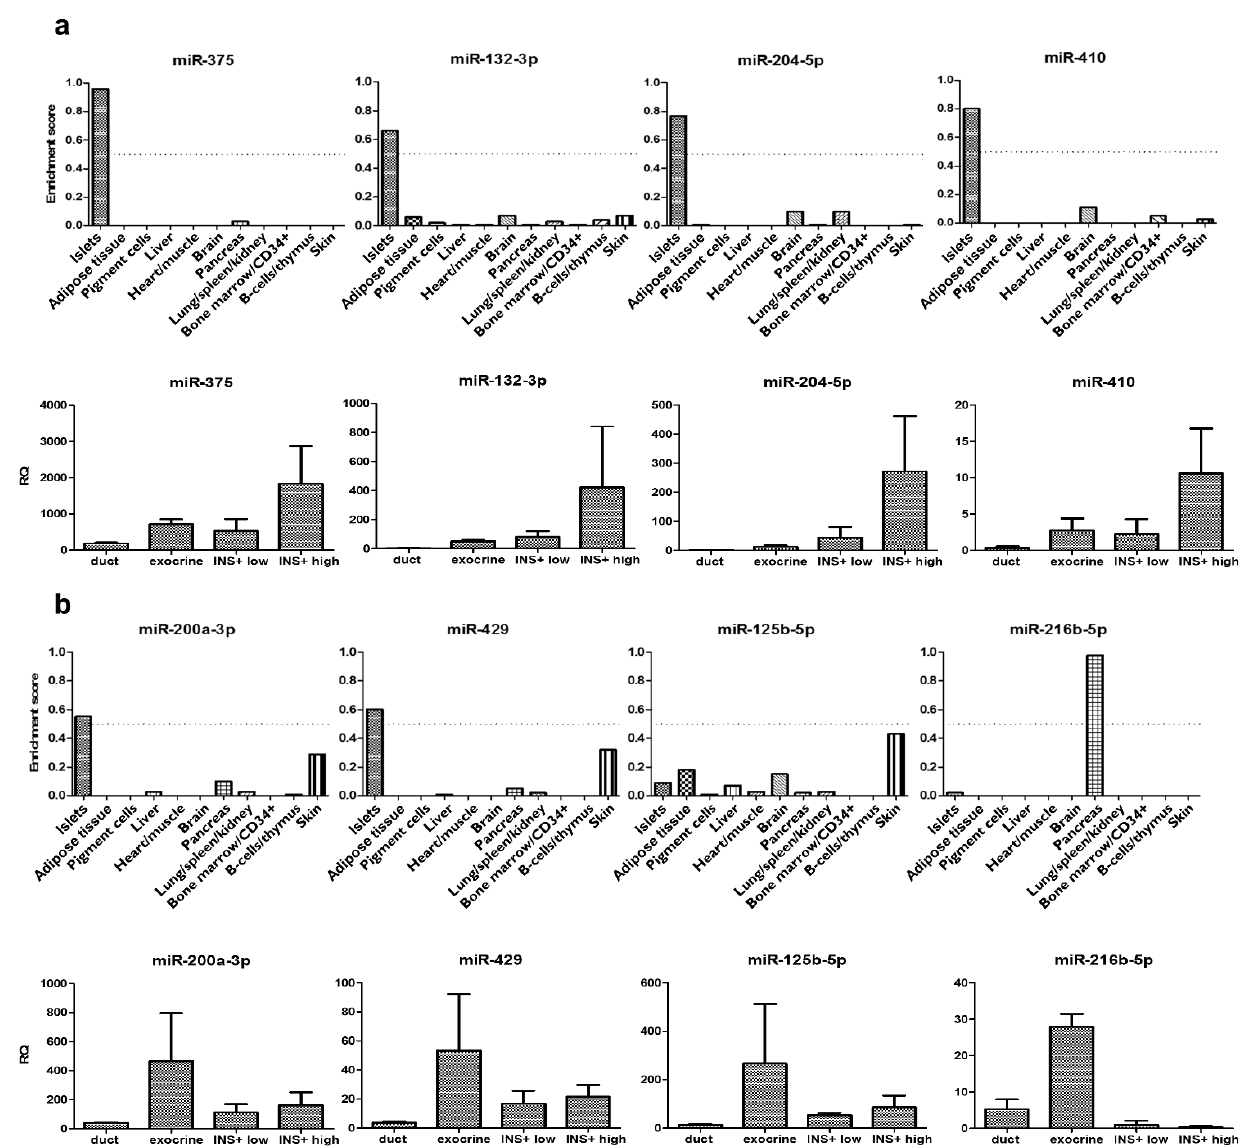
Figure 3. Relative expression levels in human pancreatic cell fractions. ( a ). set of 4 microRNA with a relative islet endocrine- enriched expression and ( b ) set of 4 microRNA with a relative pancreatic exocrine cell-enriched expression. For each set, the upper panel indicates a tissue-comparative enrichment score obtained by next-generation sequencing in human pancreatic islets ( n = 3 isolates from 6 organs) versus the other indicated tissues as derived from a public data set [10] and the lower panel the RQ measured in this study on cell preparations of human pancreas (all from n = 3 independent organ preparations), enriched in duct cells, exocrine acinar cells and islet endocrine-enriched fractions with lower (INS + low) or higher (INS + high) percentage insulin-positive cells. These fractions respectively contained 0.4%, 1.5%, 8.3% and 61.0% insulin-positive cells. Table 2. Correlation between post-transplant microRNA levels and cellular composition of the islet graft and with secre- tory graft function 2 months after transplantation. Correlations were analyzed in an independent validation cohort 3 of patients ( n = 46) receiving at least 2 million beta cells/kg BW, on RQ levels for the indicated microRNAs calculated on paired 1h post-transplant versus pre-transplant samples for each individual patient. The left panel lists the statistical sig- nificance ( p -value) of Spearman’s rank correlation of RQ to the composition of the grafts in terms of number of insulin- positive cells, C-peptide content, number of glucagon-positive cells, exocrine cells and dead cells measured just prior to implantation. The right panel indicates the correlation of RQ values to the magnitude of the C-peptide increment two months after transplantation [1,9,12] as an indicator of late-stage insulin secretory function of the graft. For correlation